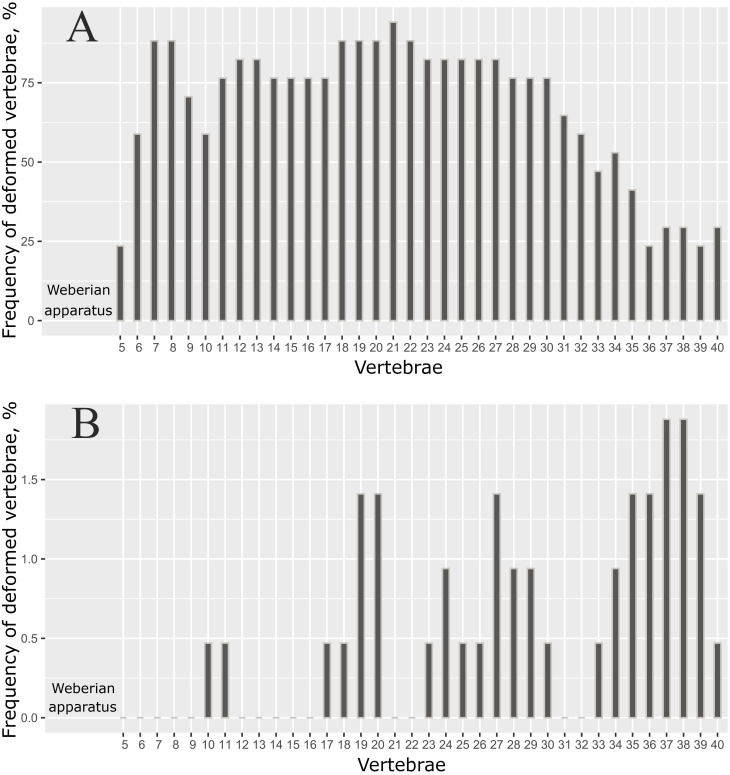
Distribution of deformed vertebrae along the vertebral column in (A) short morph (n = 17), and (B) other morphs (n = 47).Only data for individuals with 41 vertebrae are shown here; the deformities were not analyzed for the first four vertebrae (Weberian apparatus) or the 41st (pre-ural 1) vertebra.